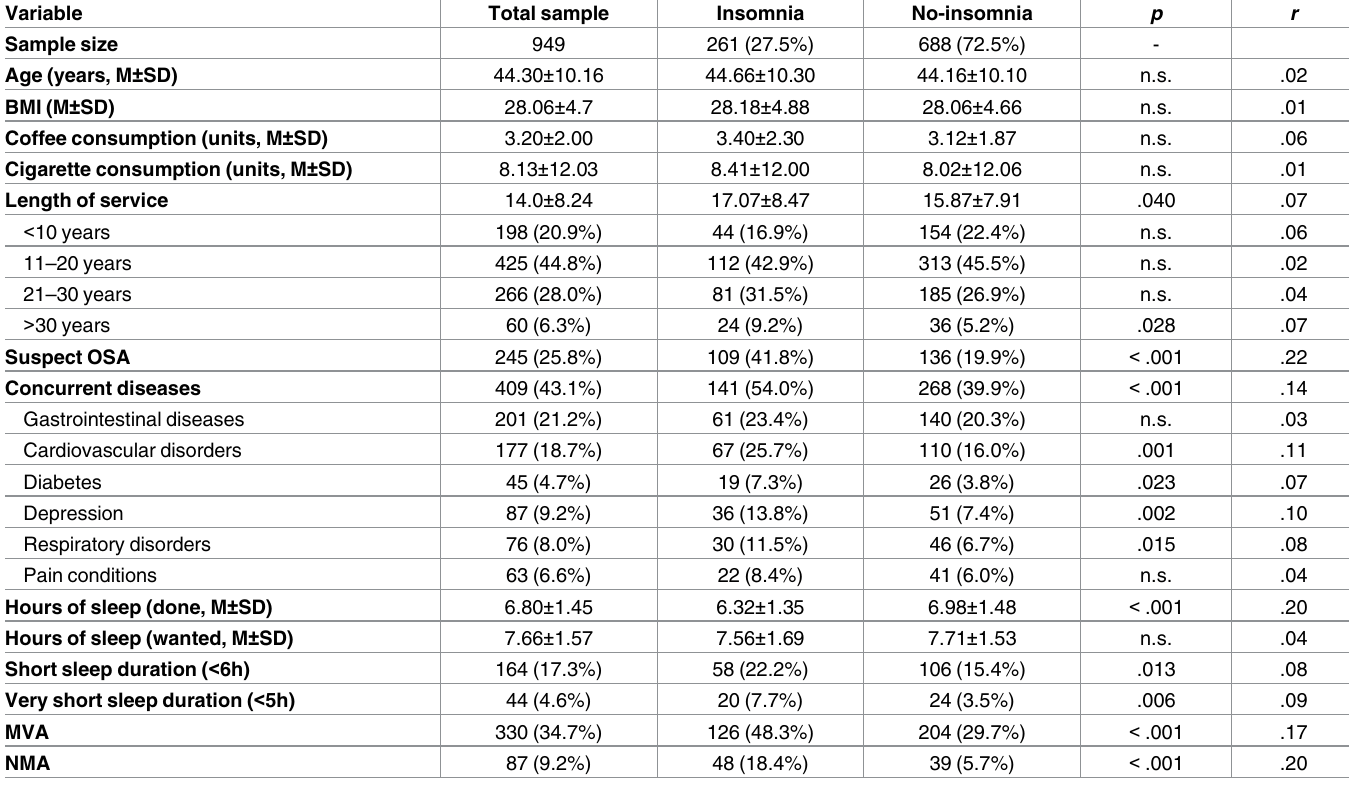
Table 1. Demographic characteristics, sleep habits, and symptoms of